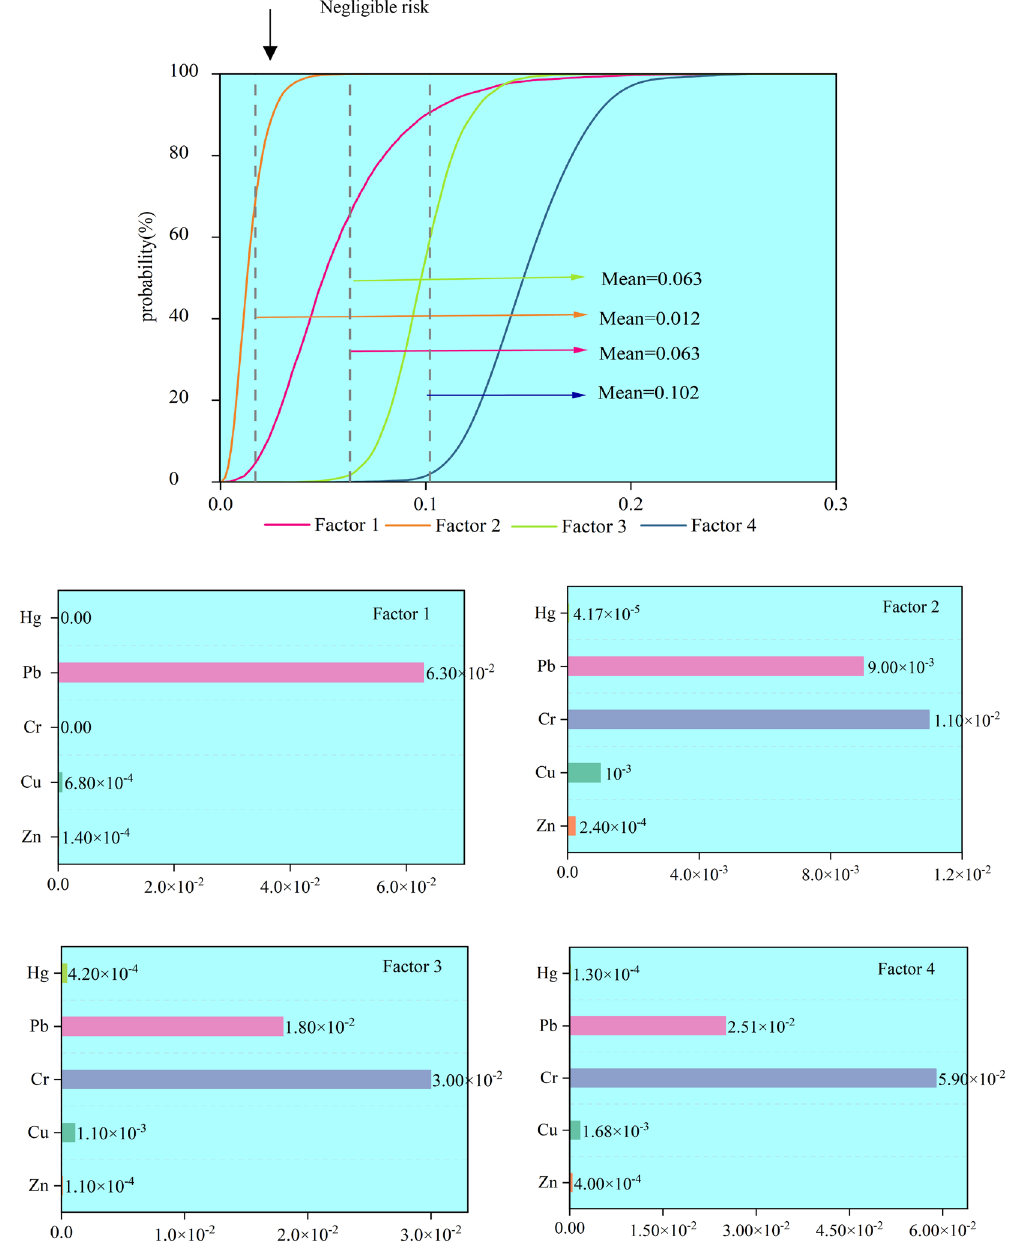
Figure 5. Probability distribution of the total NCR for children based on different sources and the NCR of each HM. Software: Origin2021. URL: https:// www. origi nlab.